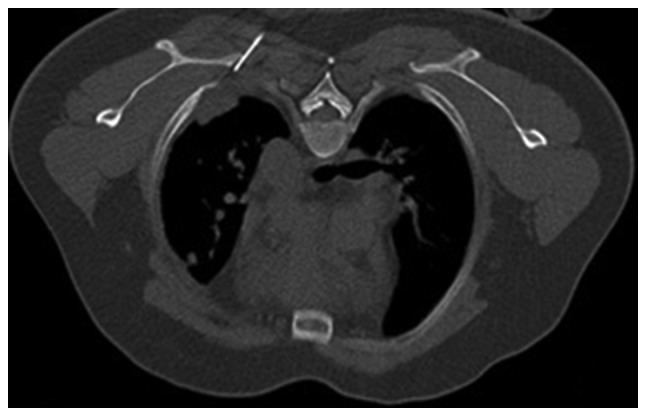
Male, aged 39 years, the first result of the computed tomography-guided cutting needle pleural biopsy was a false-negative lesion; the secondary biopsy led to a diagnosis of metastatic adenosquamous carcinoma.